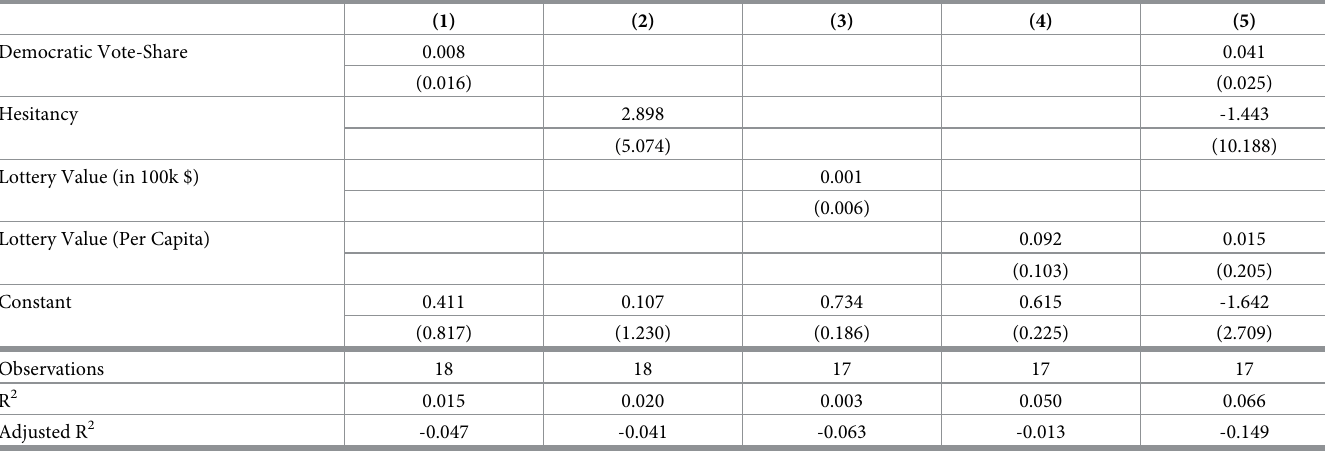
Table 1. TADD explanatory regression results (first-dose).